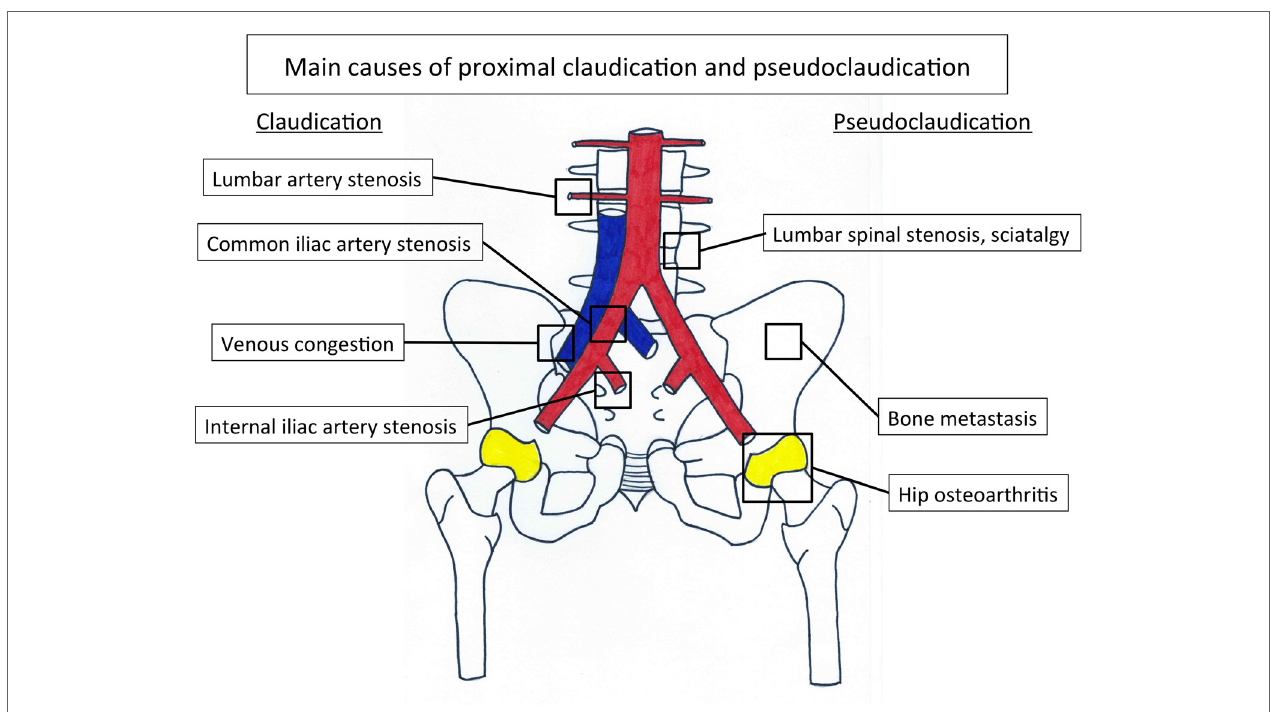
FiGURe 1 | Main causes of proximal claudication and pseudoclaudication